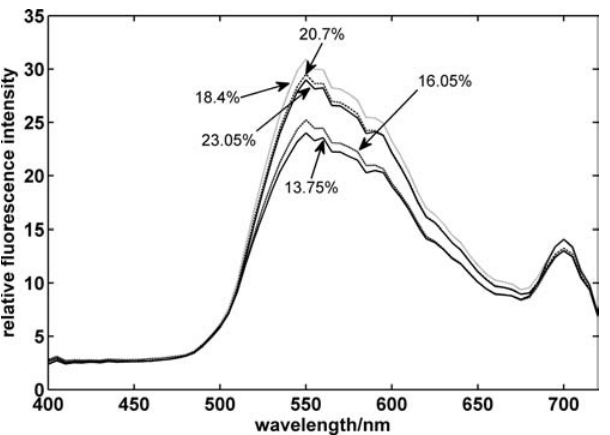
Fig. 5. The comparison of relative °uorescence intensity be- tween CBT with di®erent mass percentages of BH.